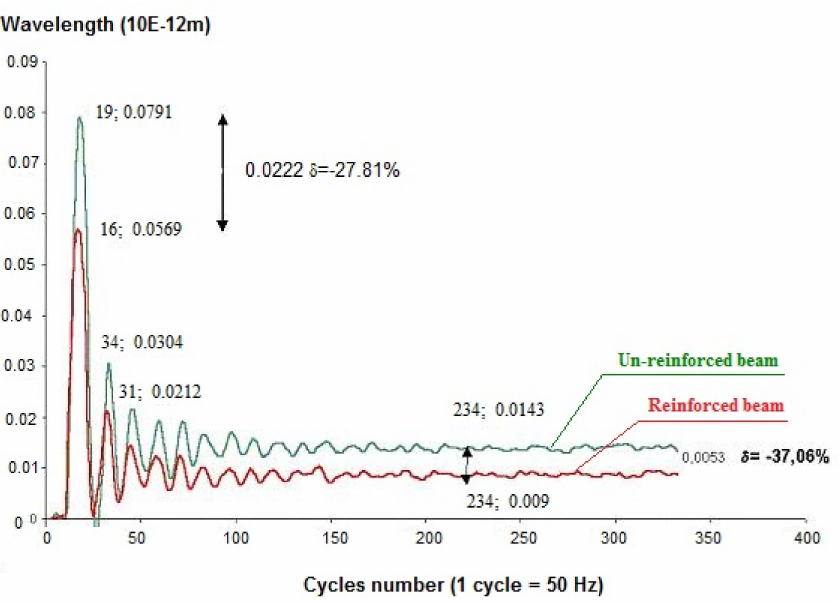
Figure 14. Comparison between the response of the reinforced and un-reinforced beam recorded at the